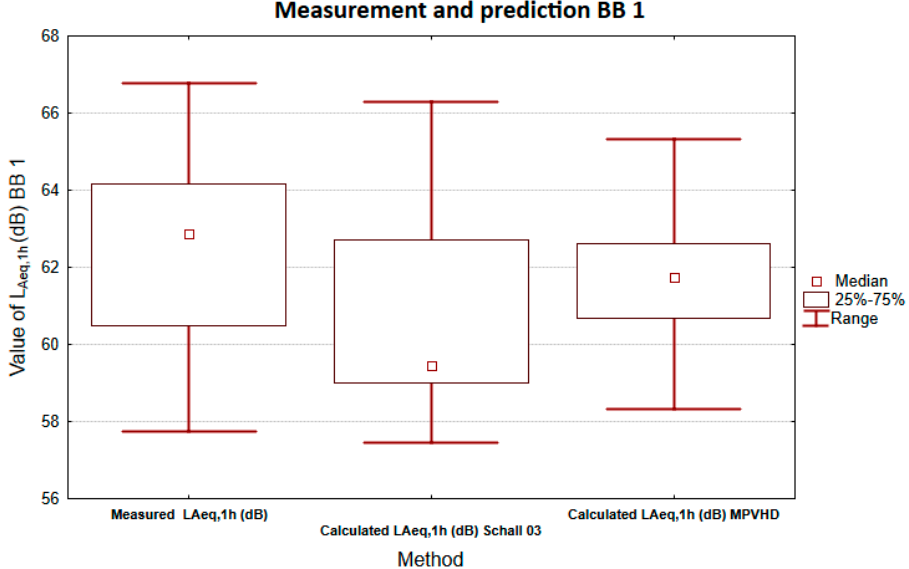
Figure 6. Comparison of equivalent sound pressure levels A using box graphs BB1.